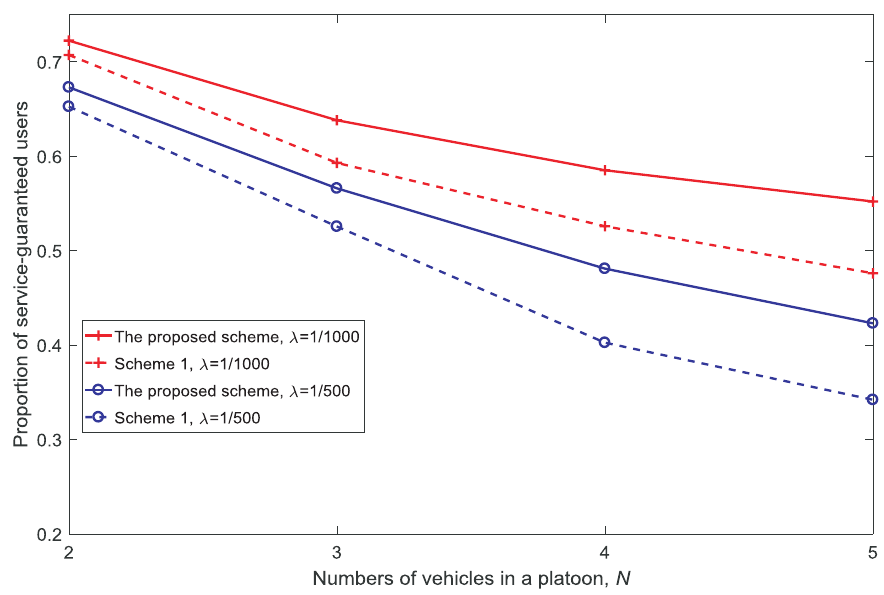
Figure 8. Proportion of service-guaranteed users for different numbers of vehicles in a platoon N ( d V = 10, K = 3, V = 10 ) .